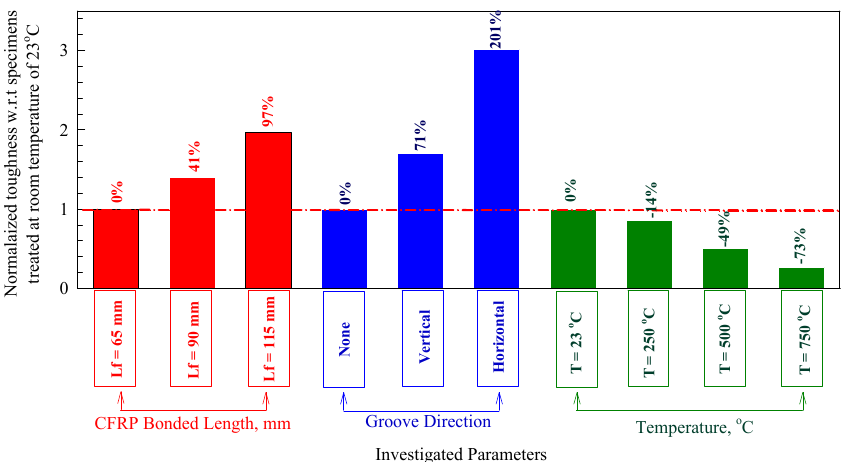
Figure 9. Normalized toughness.